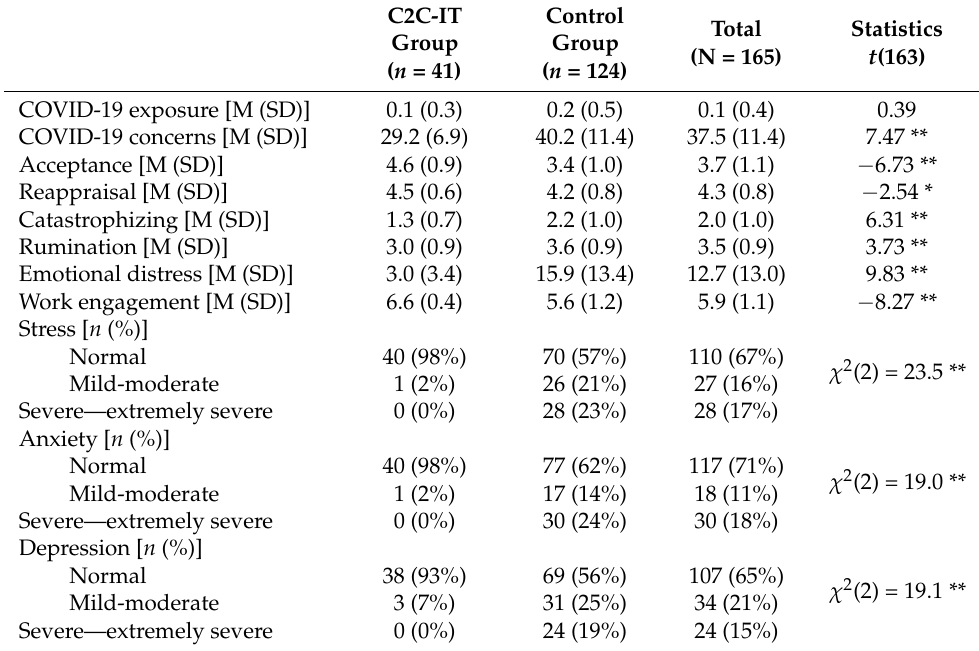
Table 2. Group differences in the research